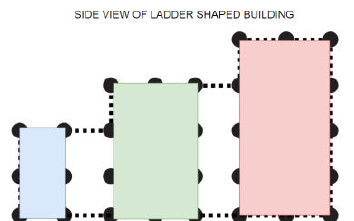
Figure 11. Side-View of the Ladder shaped building where the